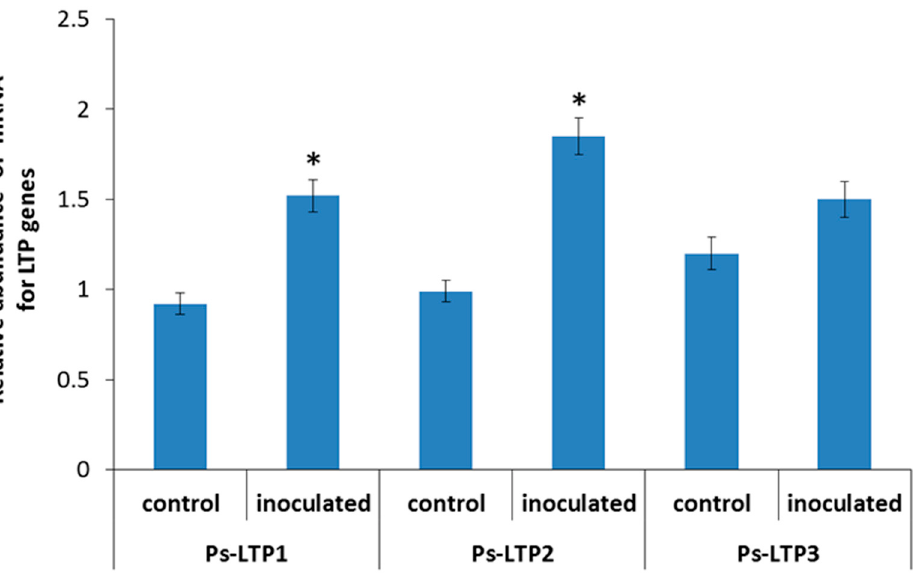
Figure 1. Relative abundance of transcripts of Ps- LTP genes (means ± s.e.) in roots of control pea plants and those inoculated with Pseudomonas mandelii IB-Ki14. The fold changes of genes normalized using the pea gene encoding tubulin (GenBank accession number X54844.1) are presented as relative units compared to control. Data sets marked with asterisks are significantly different from control (n = 3, t- test).